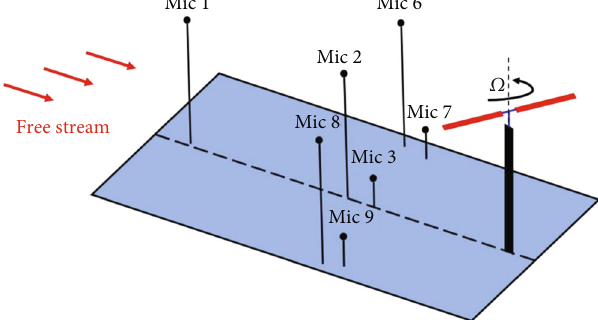
Figure 4: Microphone locations in the OLS rotor noise experiment [20, 21, 33].